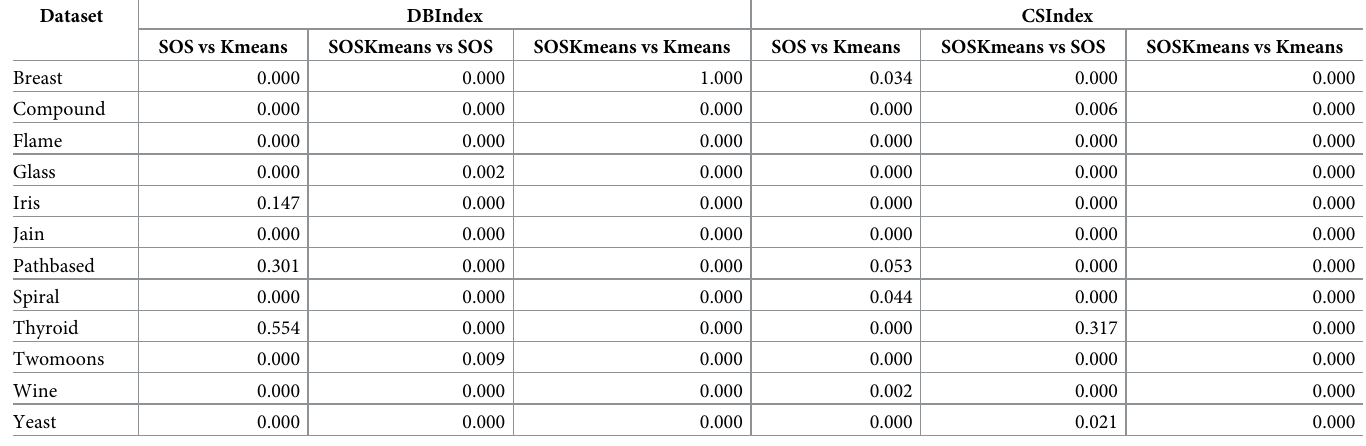
Table 9. Wilcoxon rank-sum test for equal medians showing corresponding p -values.